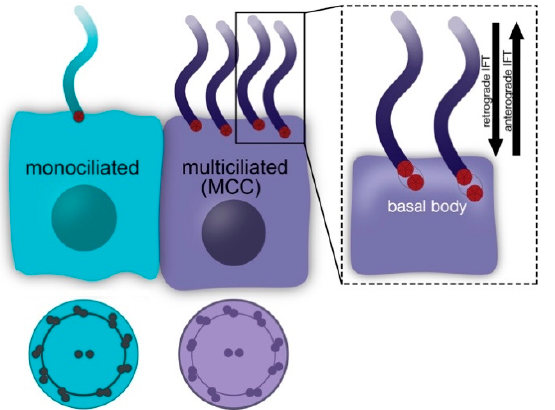
Figure 1. Comparison of the monociliated and multiciliated cell (MCC). Monociliated cells in an epithelial sheet possess a single cilium docked on the apical cell surface, which may be non-motile or motile, while the basal cell surface is adjacent to the basement membrane. By comparison, MCCs possess a multitude of cilia on their apical surface, and these exhibit coordinated movement that facilitates fluid propulsion. Each microtubule-based cilium is anchored by a basal body.